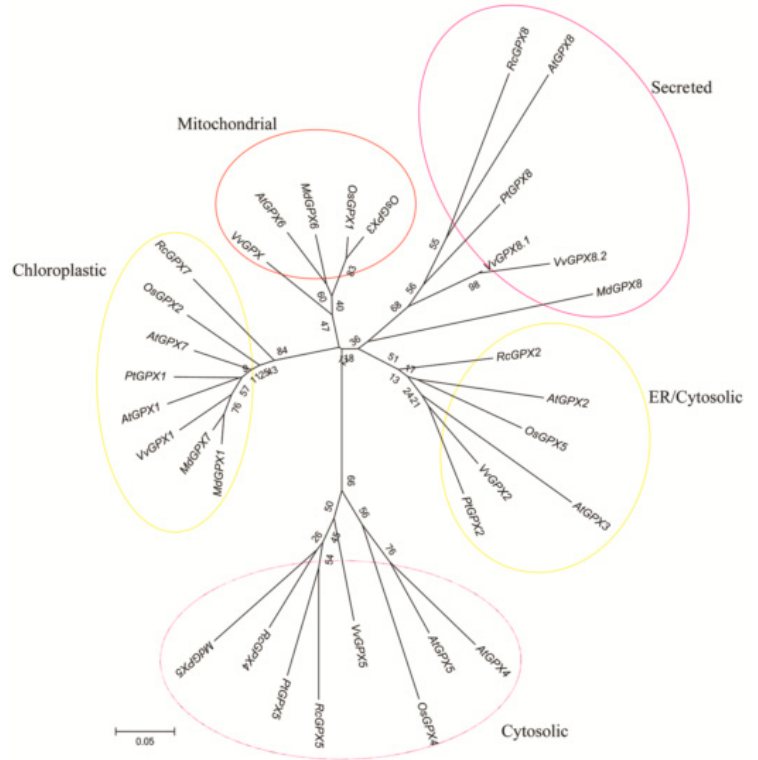
Figure 3. Phylogenetic analyses of thirty three plant glutathione peroxidase (GPX) proteins of R. crenulata and other species. The tree was constructed using the neighbor-joining method of CLUSTALW by Mega 5.0, with 1000 bootstraps, and the bar indicates 0.05 substitutions per site. Each ellipse shows a clade. The protein sequences of GPXs were followed: AtGPX1 (AT2G25080.1); AtGPX2 (AT2G31570.1); AtGPX3 (AT2G43350.1); AtGPX4 (AT2G48150.1); AtGPX5 (AT3G63080.1); AtGPX6